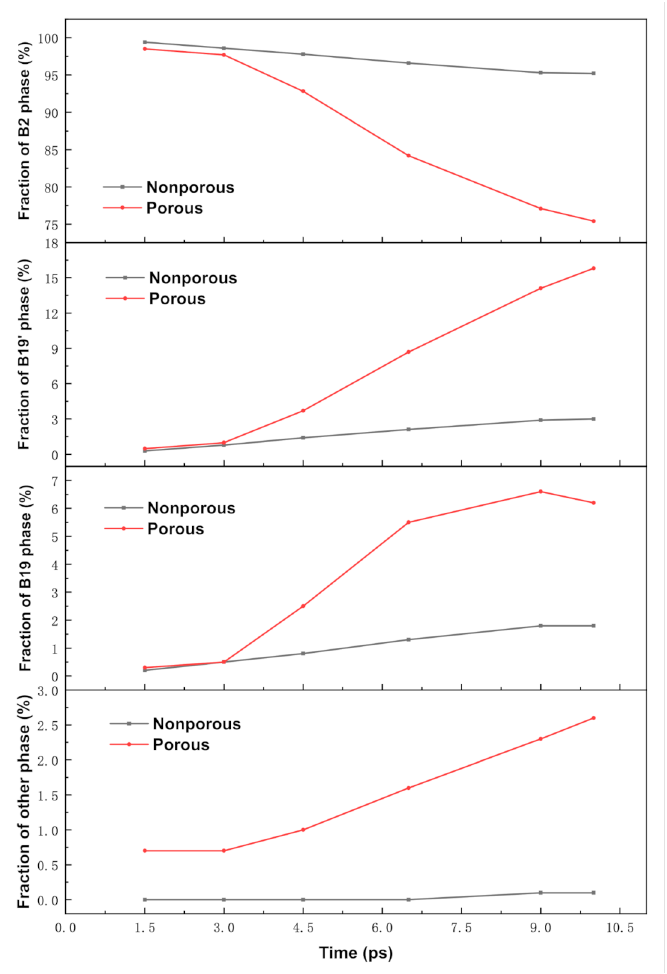
Figure 4. Microstructure components of non-porous and porous samples after forward compression loading phase change wave (obtained by PTM